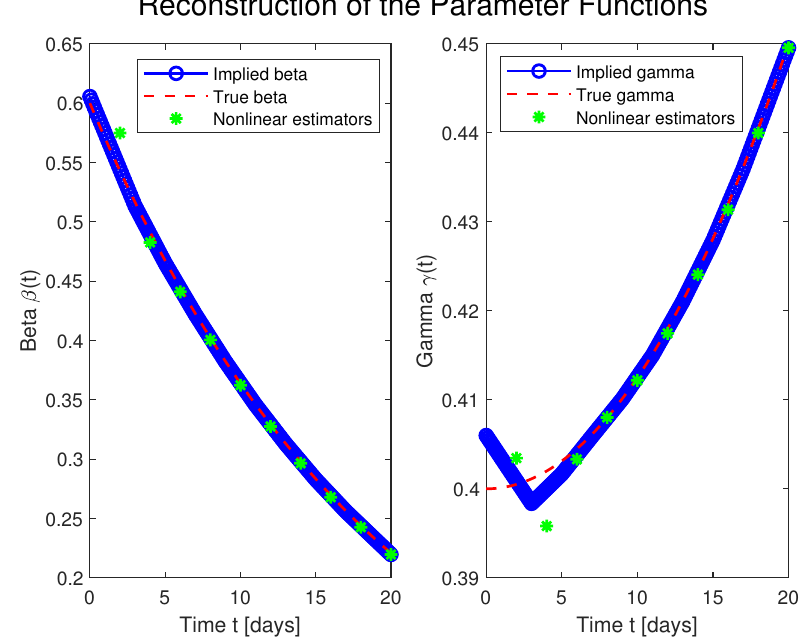
Figure 2. Recovered parameters β ( t ) and γ ( t ) with (12).